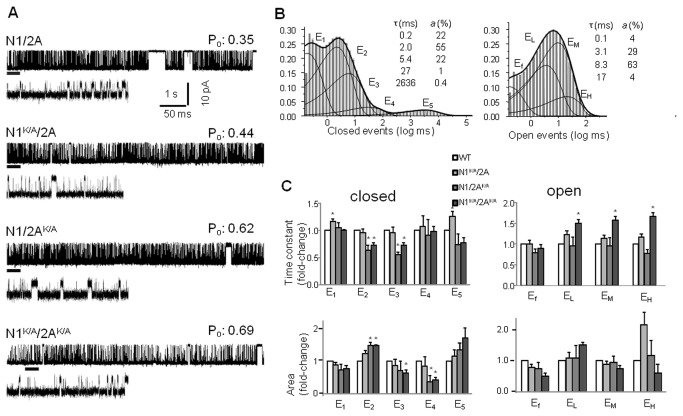
Single channel activity of NMDA receptors with side-chain truncation in the LBD cleft.(A) Currents were recorded from attached patches of HEK293 cells expressing N1KE/N2AKN, N1K/A/2A, N1/2AK/A, or N1K/A/2AK/A receptors (B) Dwell time histograms for closed and open events recorded from one N1/N2A channel (799,601 events). Thin lines represent exponential components; insets give the time constants (τ) and relative areas (a) for these components. (C) Summary of changes in time constants (top) and areas (bottom) for closed and open components for the mutations examined. *, indicates significant changes relative to N1/2A receptors (p<0.05, Student’s t-test).